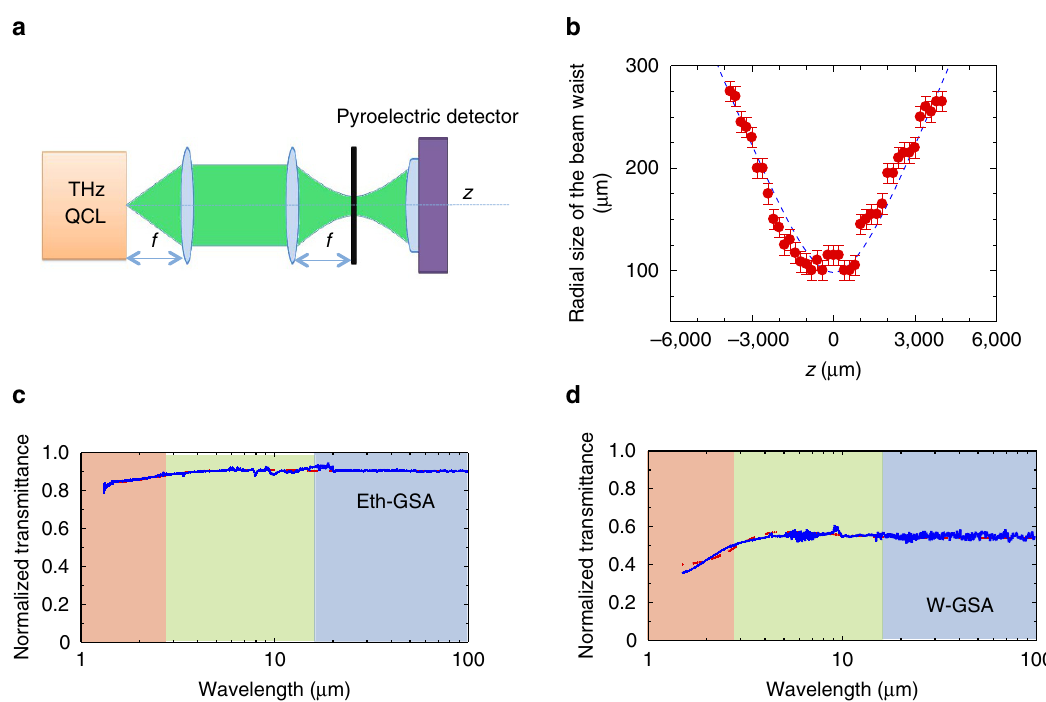
Figure 5 | Z-scan and FTIR measurements. ( a ) Schematic diagram showing the open aperture z-scan setup; ( b ) beam waist (radial spot size) profile measured at different positions along the optical axis z , of the single-plasmon 3.5THz QCL operating in pulsed-mode with a pulse width of 2 m s, a modulation frequency of 200kHz, under an applied field of 7.6kVcm (cid:2) 1 . The error bars represent the uncertainty associated with the measurement of the ffiffiffiffiffiffiffiffiffiffiffiffiffiffiffiffiffiffiffiffiffiffiffi (cid:2) (cid:3)q allows to retrieve a radial spot size w B 95 ± 6mm. ( c , d ) FTIR transmittance of 1 þ z 2 (cid:6) z 2 radius of the beam spot. The fitting function w ð z Þ¼ w 0 0 R ( c ) Eth-GSA and ( d ) W-GSA normalized to the transmittance of the SiO 2 /Si substrate, in the NIR, MIR and THz spectral ranges. The spectra collected separately in the three spectral ranges are plotted together. A white light source is employed in all cases combined with a PbSe detector (NIR) DTGS KBr detector (MIR) and DTGS-polyethylene detector